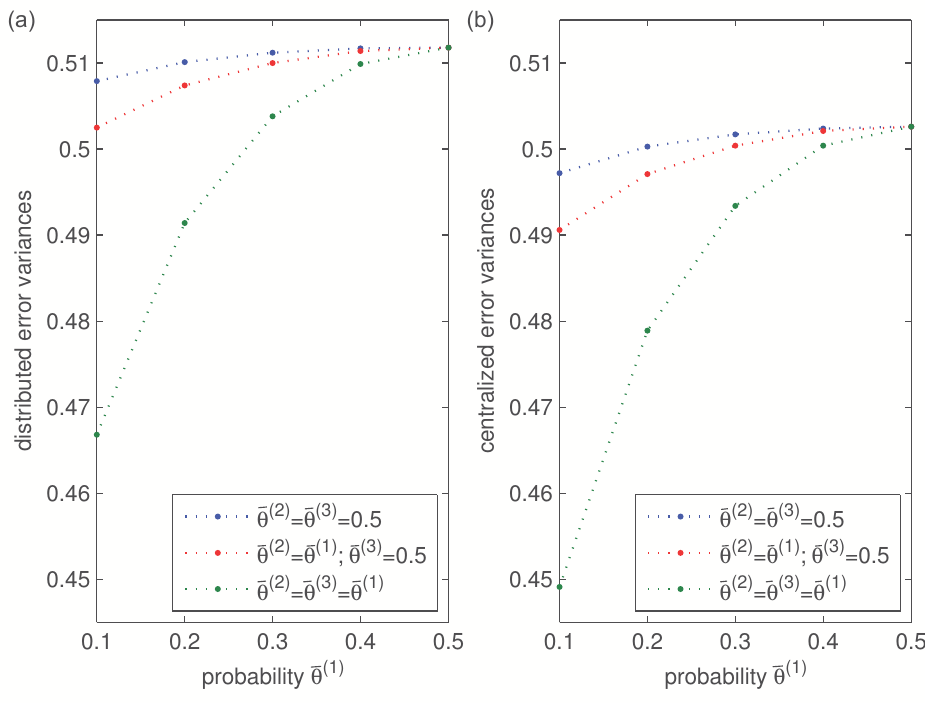
Figure 3. ( a ) Distributed filtering error variances and ( b ) centralized filtering error variances at k = 100, ( 1 ) versus θ